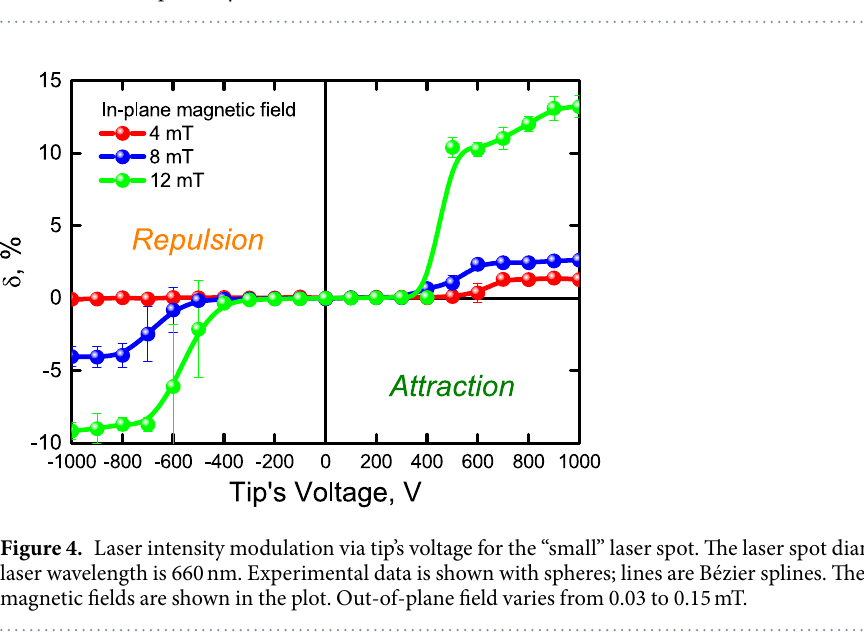
Figure 3. Laser intensity modulation via tip’s voltage for the “large” laser spot. The laser spot diameter is 6 μ m; laser wavelength is 660 nm. Two different types of the DW-tip interaction are investigated: ( a ) repulsion and ( b ) attraction. Experimental data is shown with spheres; insets on ( b ) show the DW positions with tip’s voltage growing. In ( a ) the black line is the linear fitting of the experimental points for tip’s voltage magnitudes higher 300 V, the blue line is the quadratic fitting; other lines in ( a ) and ( b ) are Bézier splines. The in-plane magnetic fields are shown in the plots; the out-of-plain fields are 0.15, 0.3, 0.45, and 0.6 mT for the in-plane fields of 13, 20, 24, and 27 mT, respectively.